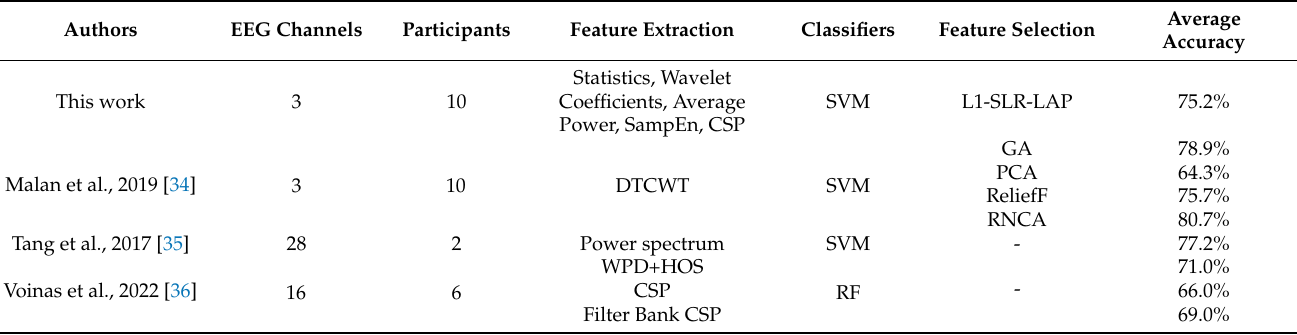
Table 6. Comparison of classification accuracies among different datasets and